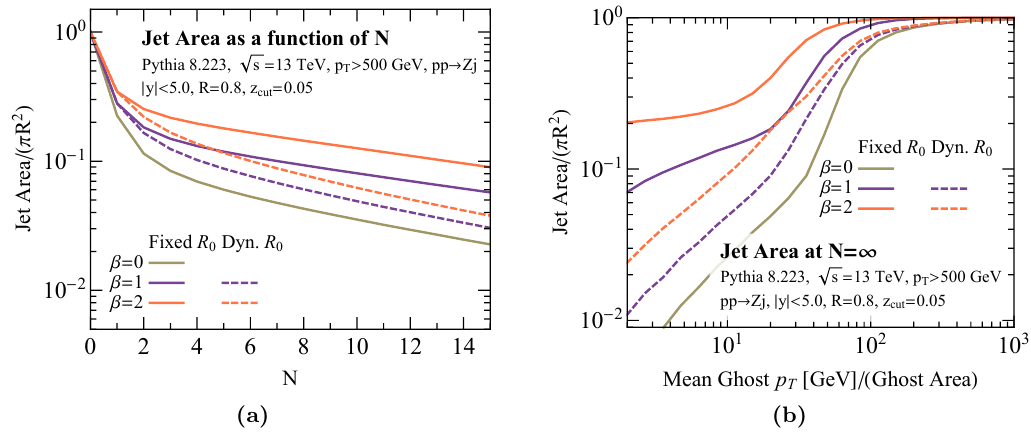
Figure 5. Jet area studies on quark/gluon jets in pp ! Zj events, for the (cid:12)xed R 0 (solid line) and dynamic R 0 (dashed line) algorithms. (a) Active jet area as a function of the number of soft drop layers N . (b) Active jet area as a function of ghost transverse momentum density (cid:26) for RSD 1